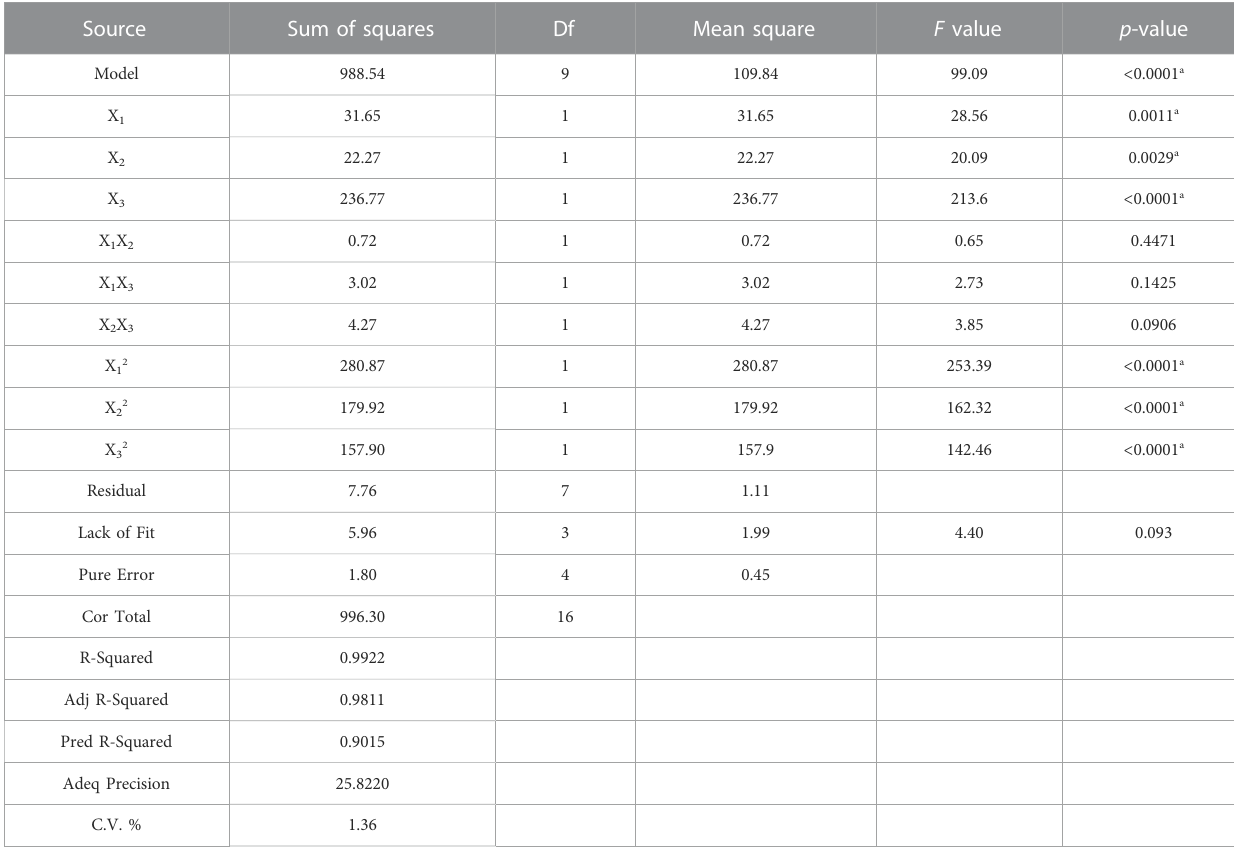
TABLE 2 Variance analysis (ANOVA) of the response surface quadratic model for culture medium optimizaition. Source Sum of